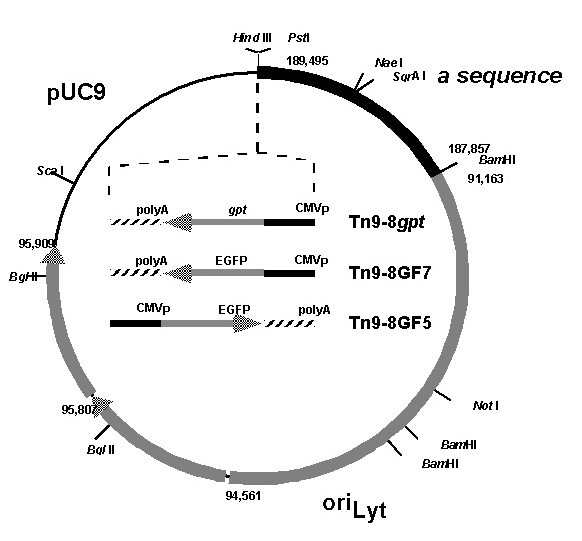
Schematic representation of the HCMV amplicon plasmids Tn9-8gpt, Tn9-8GF7 and Tn9-8GF5. The EGFP expression cassette was cloned in two orientations in the unique PstI site in Tn9-8. The gpt expression cassette was cloned between the unique PstI and HindIII sites.